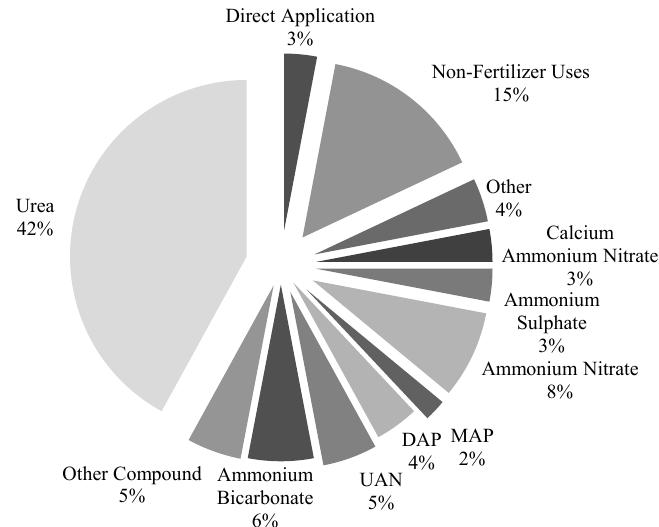
Figure 1. The applications of ammonia, reproduced from Reference [1].